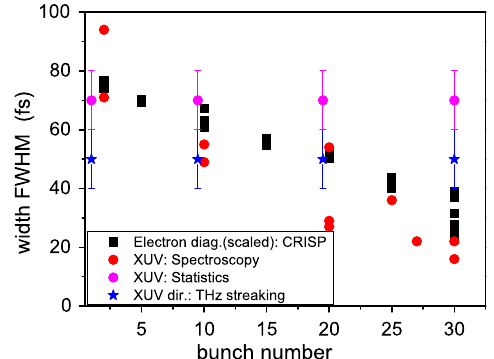
FIG. 15. XUV and electron bunch duration (FWHM) measure- ments of the pulse-resolved methods for the 24 nm run. All measurements of the run have been plotted as a function of the bunch number within the bunch train. The measurements result from different shifts (see Fig. 16). While CRISP (the electron duration is scaled by 0.66) and spectral analysis see a strong decrease of the pulse duration, terahertz streaking and statistical analysis measure no change of the pulse duration within the bunch